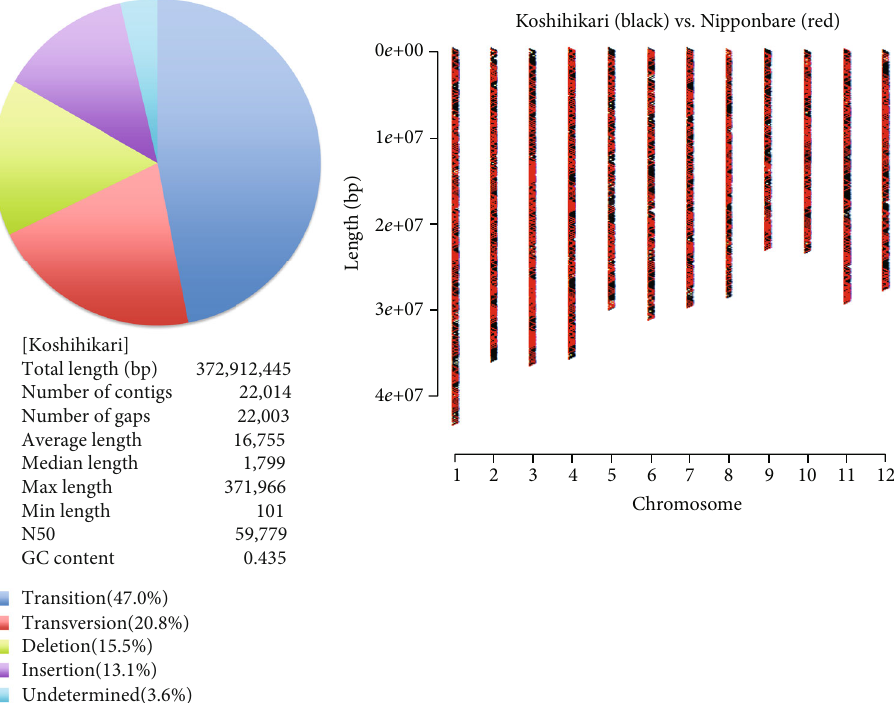
Figure 3: Construction of consensus genome of Koshihikari by whole-genome sequencing by next-generation sequencing. Read sequences gained from Koshihikari genome were mapped by using the Nipponbare genome as a reference sequence. As a result, a complete length bp of Koshihikari consensus sequence was determined with 99.0% cover ratio at the average depth of 35.68. Polymorphisms found